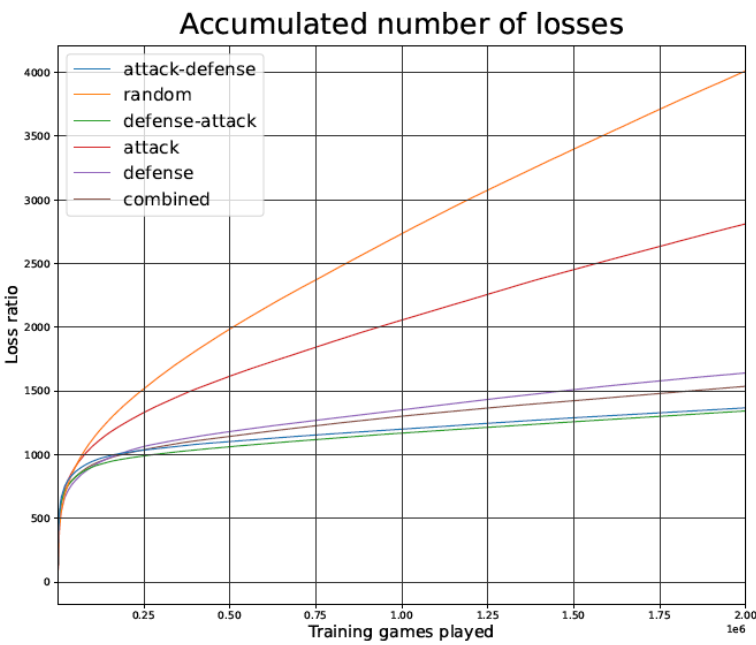
Figure 12. Games lost by the Connect-4 TD agent during the training phase as a function of the number of games played, for the different training strategies.